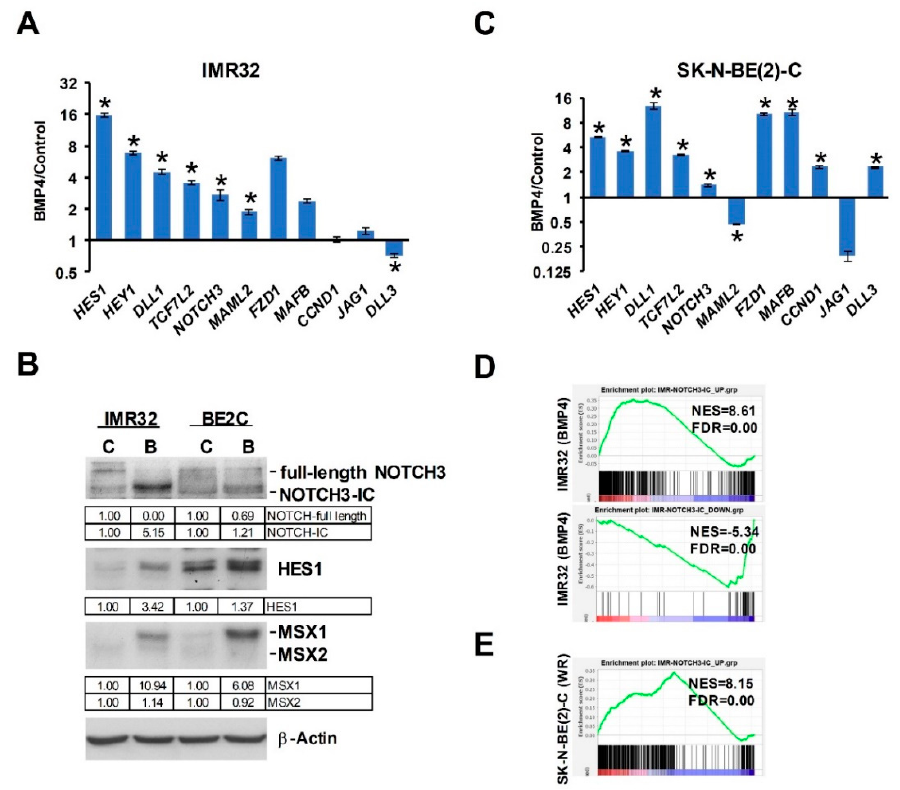
Figure 7. BMP4 and Wnt regulate Notch signaling in neuroblastoma. ( A ) Regulation of Notch pathway genes by BMP4 in IMR32 cells, detected by qPCR. Statistically significant di ff erences ( p < 0.05) are indicated by asterisks ( n = 3). ( B) BMP4 treatment leads to NOTCH3 cleavage, upregulation of Notch target / e ff ector protein HES1 and MSX1 / 2 proteins in IMR32 and SK-N-BE(2)-C cells. ( C ) Regulation of Notch pathway genes by BMP4 in SK-N-BE(2)-C cells, detected by qPCR ( n = 3). ( D ) GSEA of RNA-seq data sets of BMP4-treated IMR32 and ( E ) Wnt3a / Rspo2-induced SK-N-BE(2)-C with NOTCH3-IC target gene sets identified in